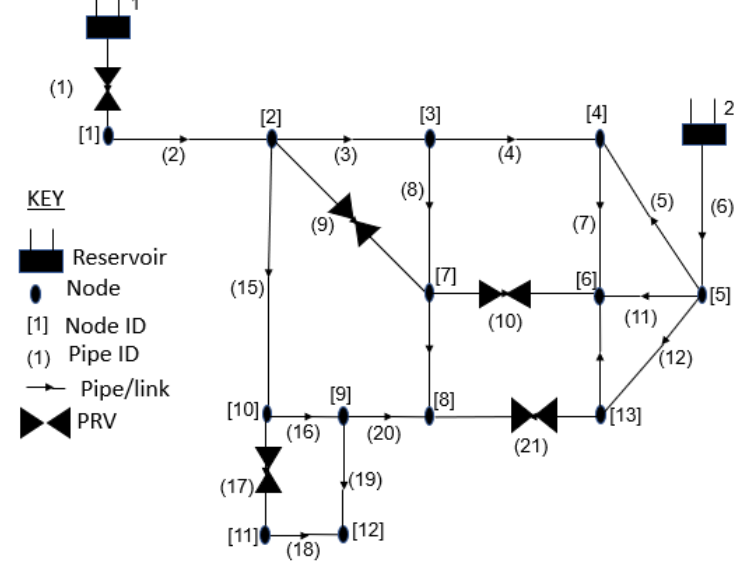
Figure 2. Schematic diagram for case study